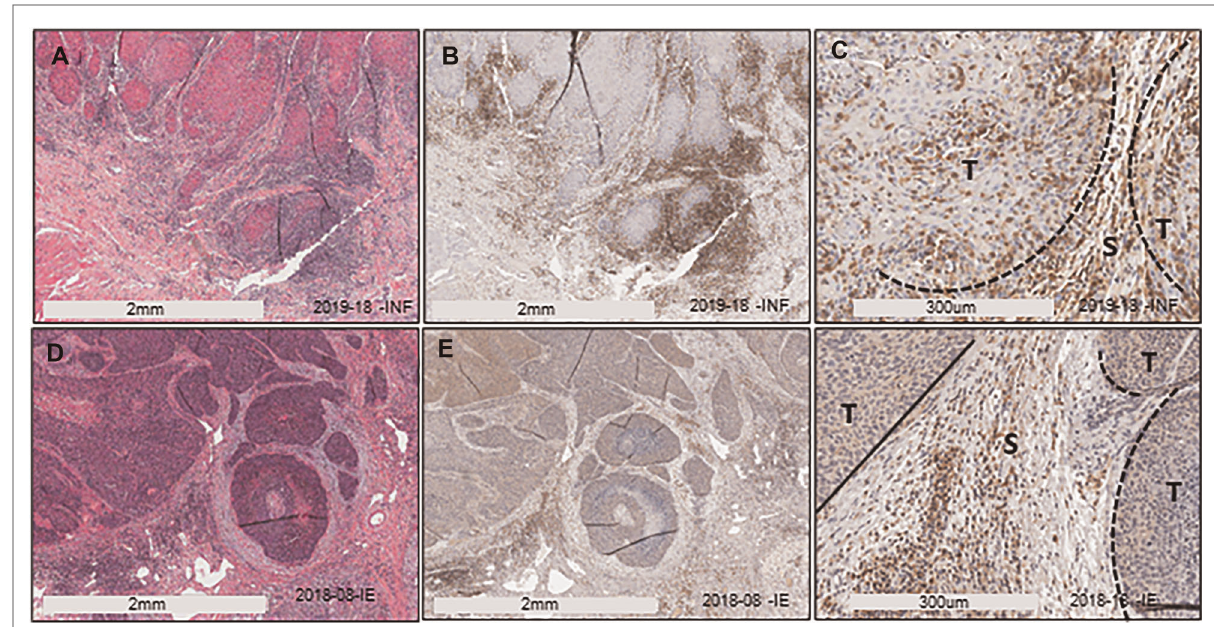
FIGURE 1 HIS strati fi cation in HNSCC. ( A ) H&E stain of HIS-INF OSCC. ( B , C ) IHC of Sema4D illustrating HIS-INF. ( D ) H&E stain of HIS-IE SCC on the base of the tongue. ( E , F ) IHC of Sema4D illustrating HIS-IE ( E : low power; F : higher power). HIS, histological in fl ammatory subtype, HIS-INF, HIS in fl amed, HIS-IE, HIS immune excluded, T, tumor islands, S,